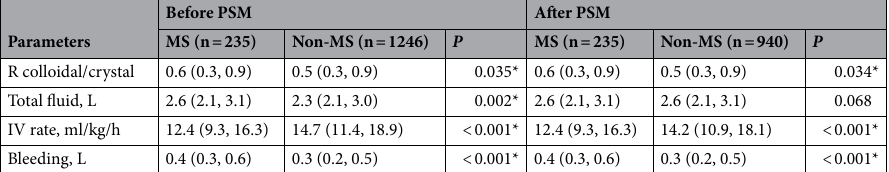
Table 2. Intraoperative fluid management between MS and non-MS. * P value was less than 0.05, with statistical significance. MS Metabolic syndrome, PSM Propensity score matching, Non-MS